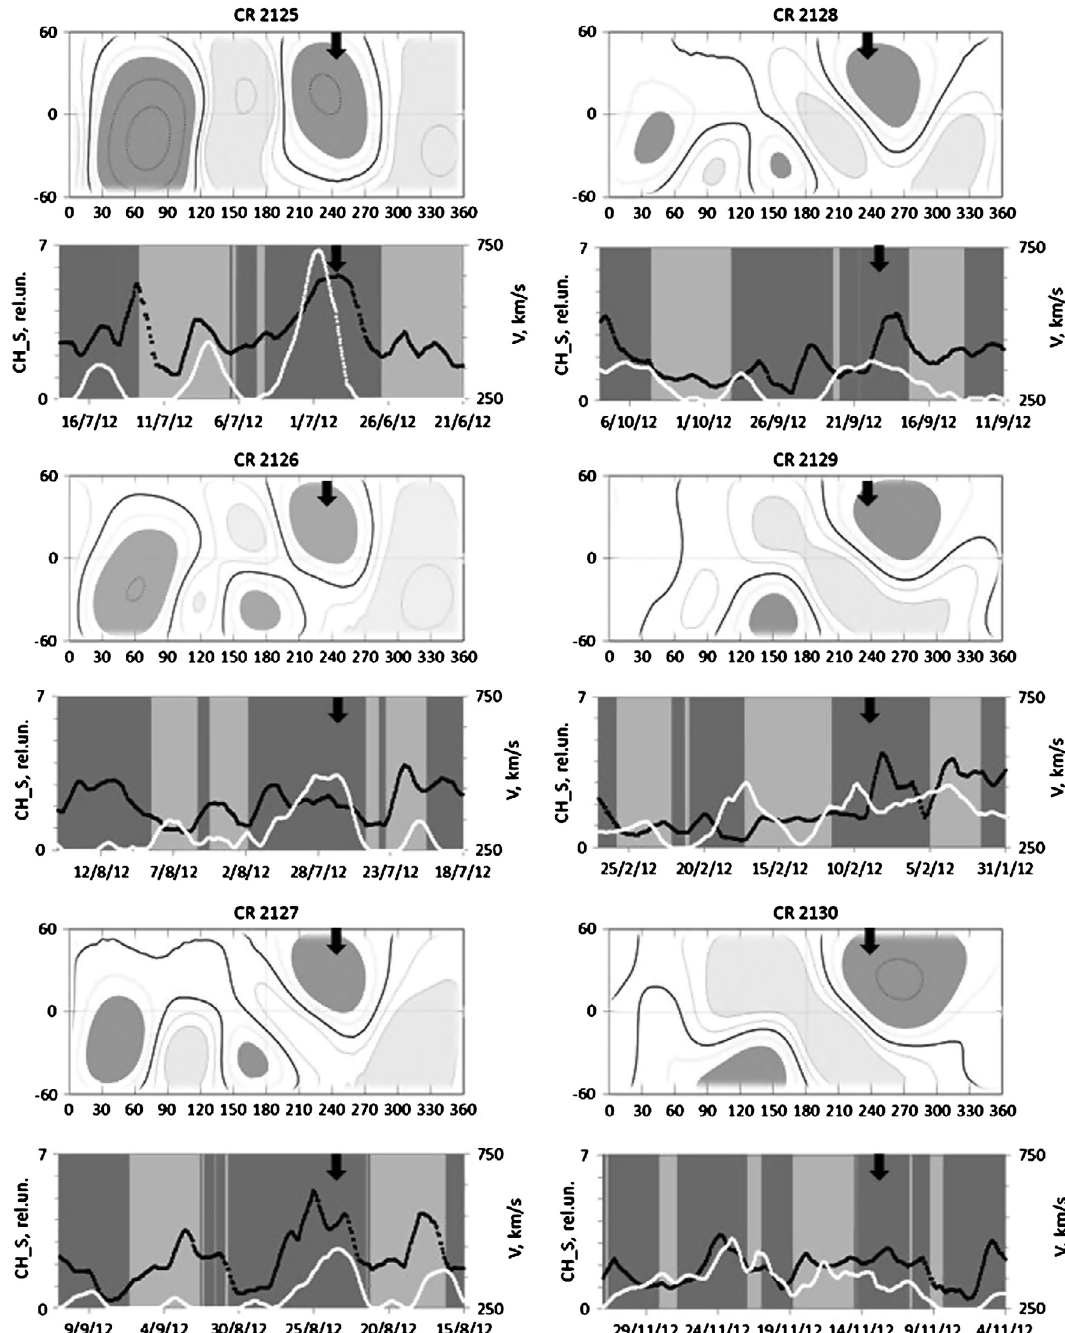
Figure 2b. Same as Figure 2a, but during CR